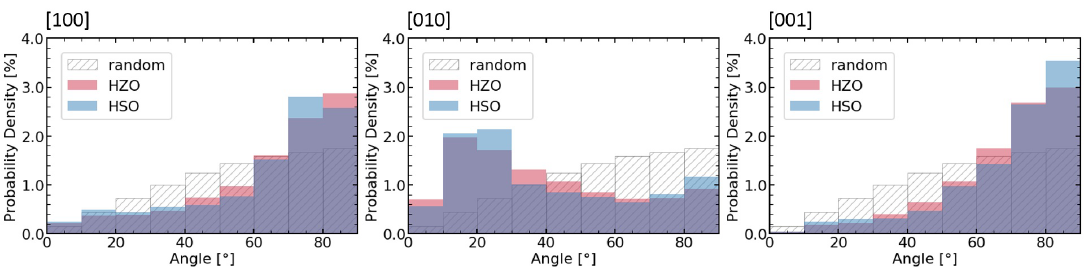
Figure 8. Textures of the <100>-axes are visualized by the angle distribution of the axis and sample normal. For comparison, the distribution of 100,000 randomly oriented vectors is